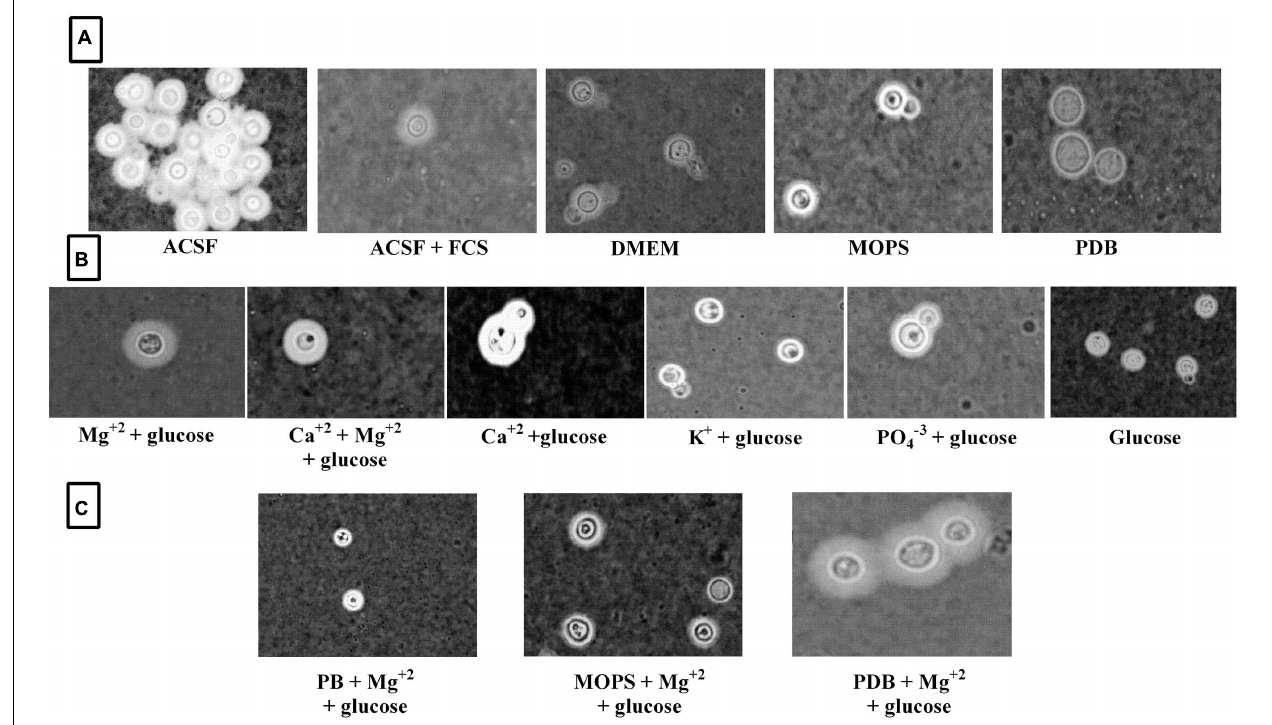
FIGURE 8 | Clinical C. neoformans capsule induction in different media. (A) Capsule induction in different media; (B) Capsule induction in individual ACSF salts; (C) Capsule induction in different media supplemented with Mg 2 +